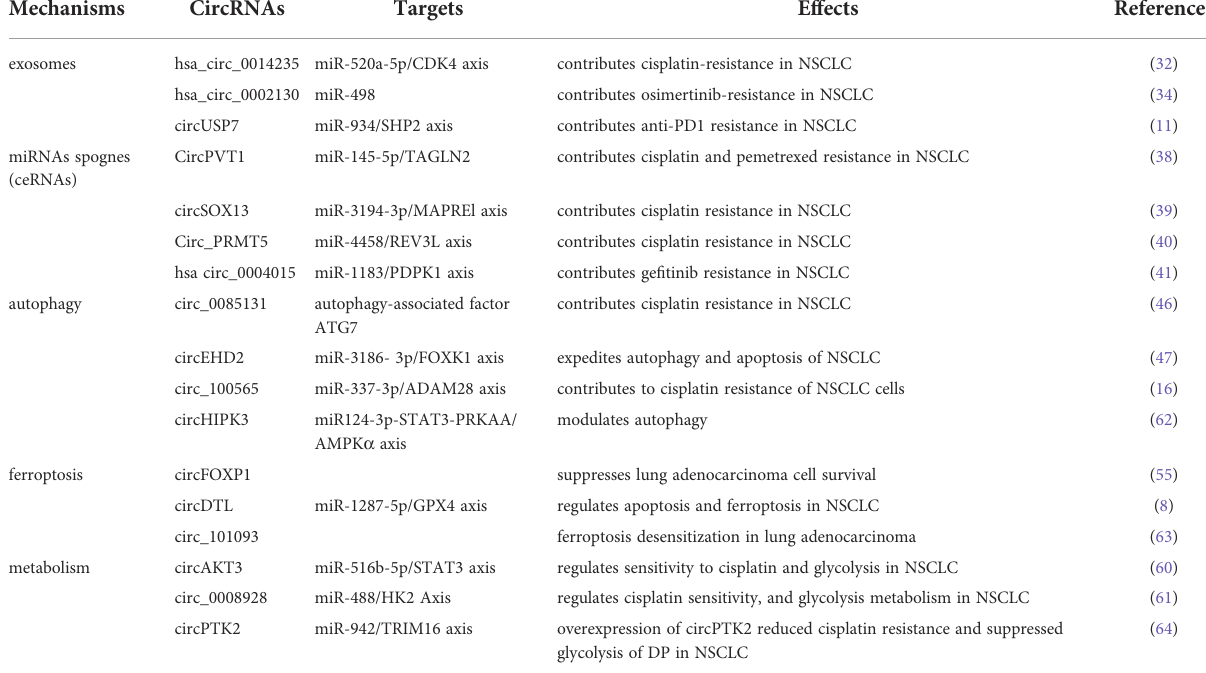
TABLE 1 The potential mechanisms of circRNAs in